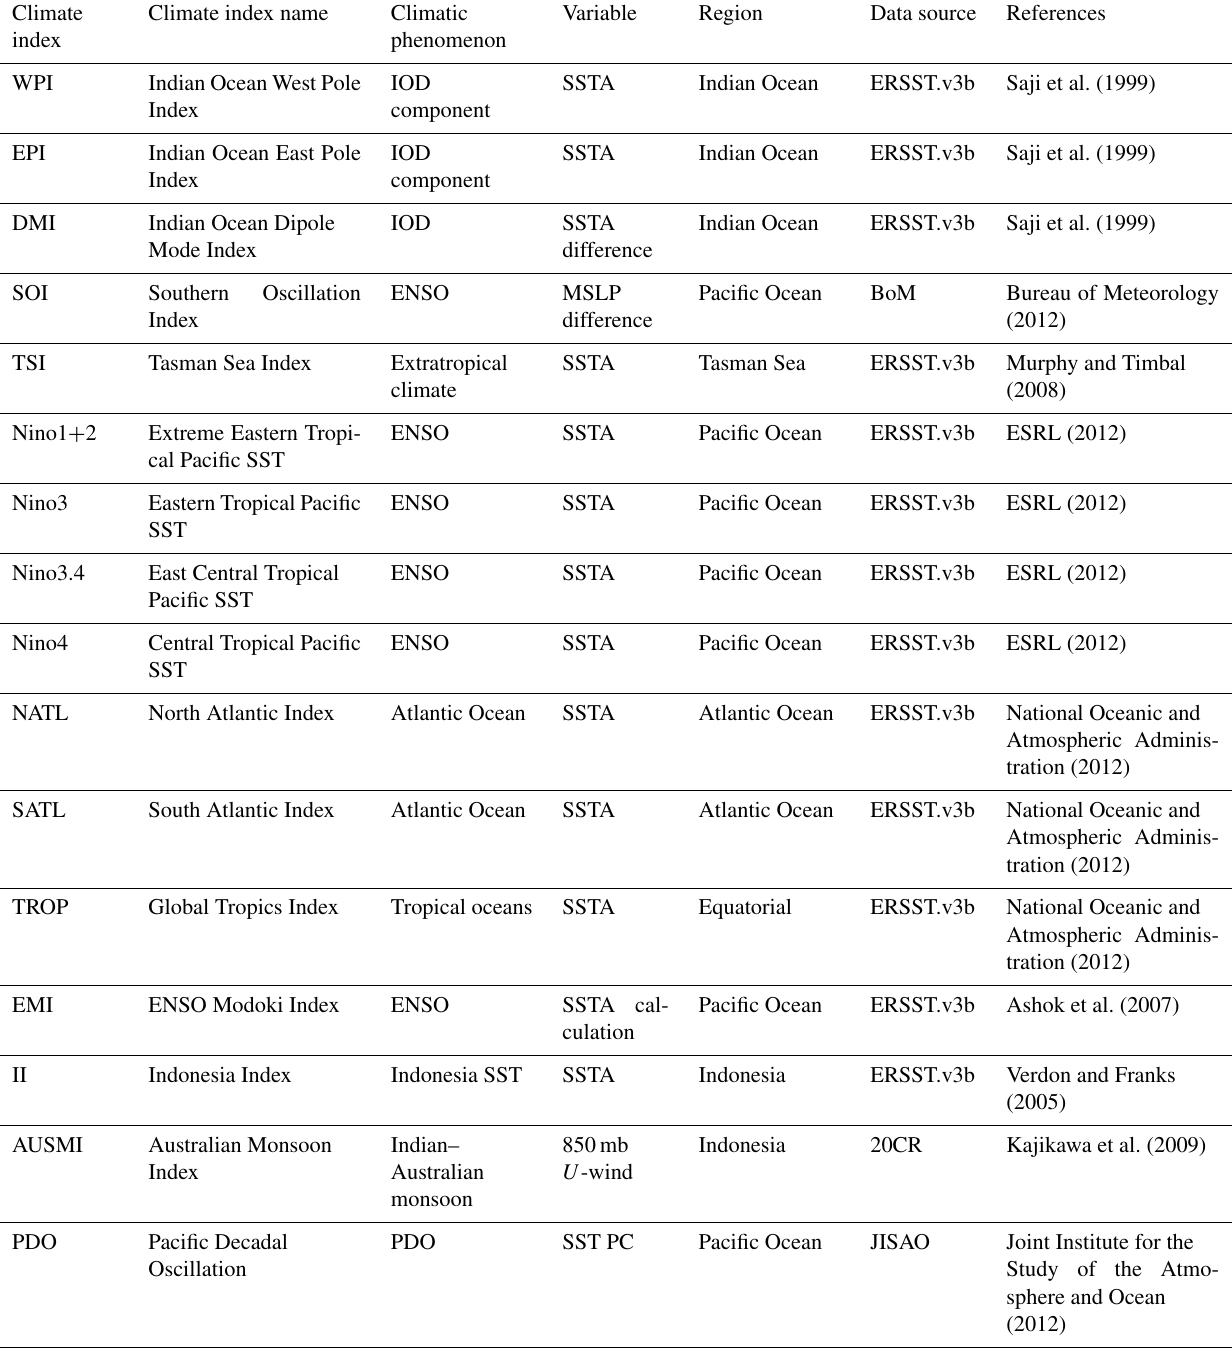
Table 2. Climate index information showing index name, related climatic phenomenon, variable measured, region of influence, data source and a key